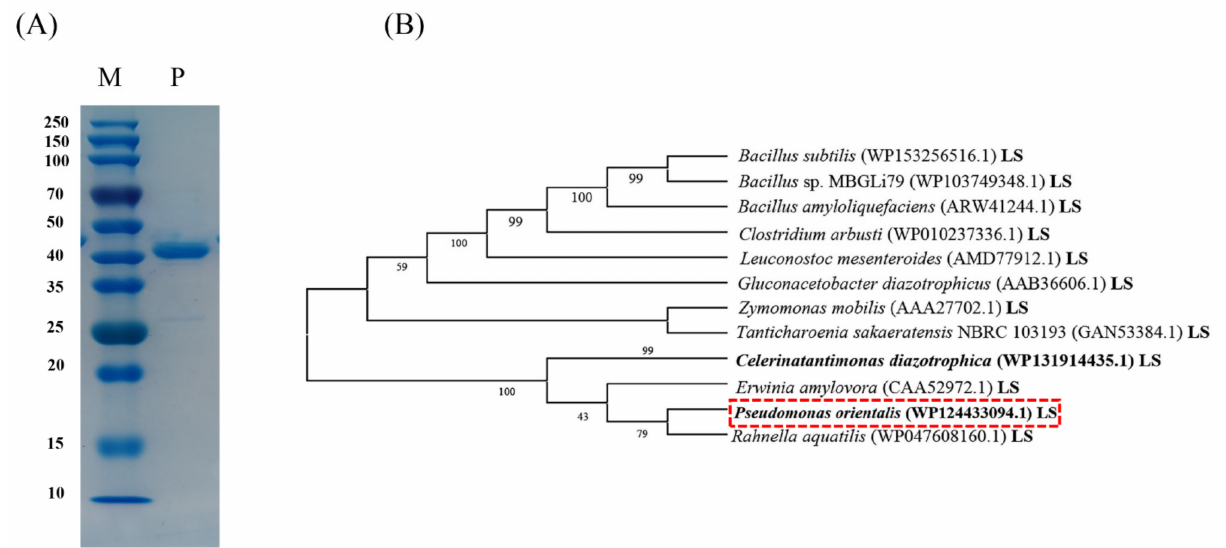
Figure 2. SDS-PAGE and phylogenetic tree. ( A ) Lane P represents the purified LS from P . orientalis , and lane M represents the protein marker with standard enzymes with the following molecular weights: 250, 150, 100, 70, 50, 40, 35, 25, 20, 15, and 10 kDa. ( B ) Phylogenetic tree of LSs from different sources. The phylogenetic tree was constructed by MEGA 5.1. The content in the bracket is the accession numbers in the GenBank